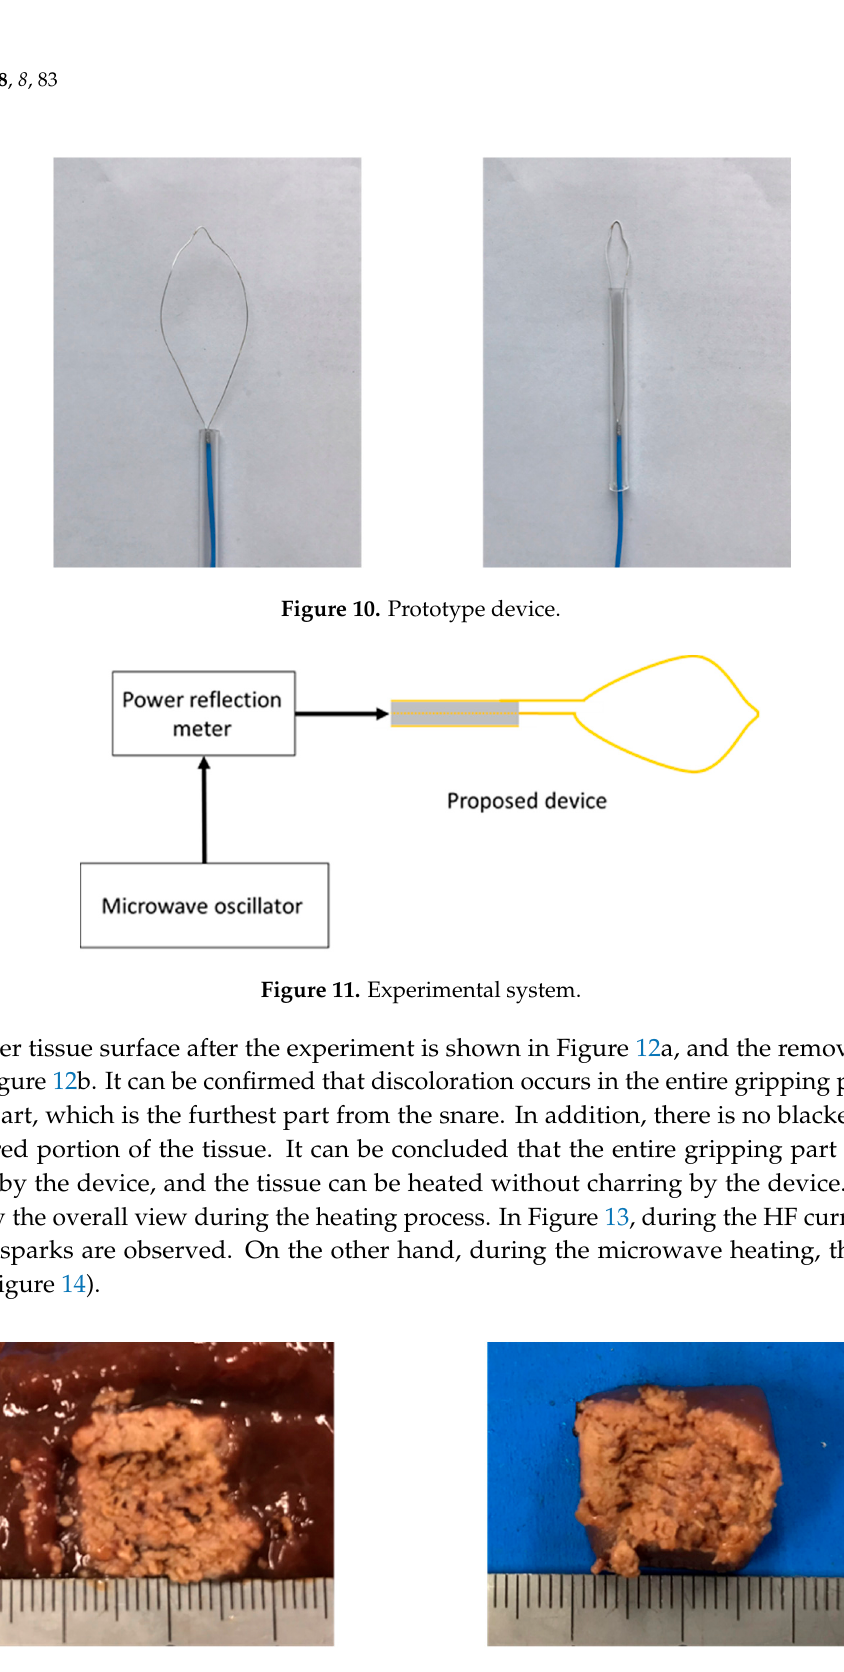
Figure 12. Liver tissue surface after the experiment.